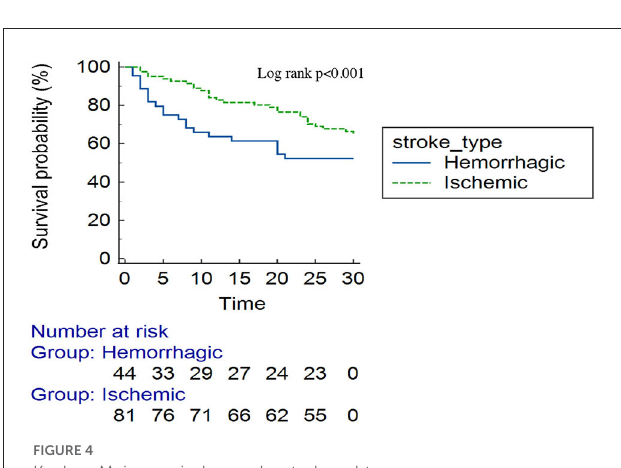
FIGURE4 Kaplan–Meier survival curve by stroke subtype.